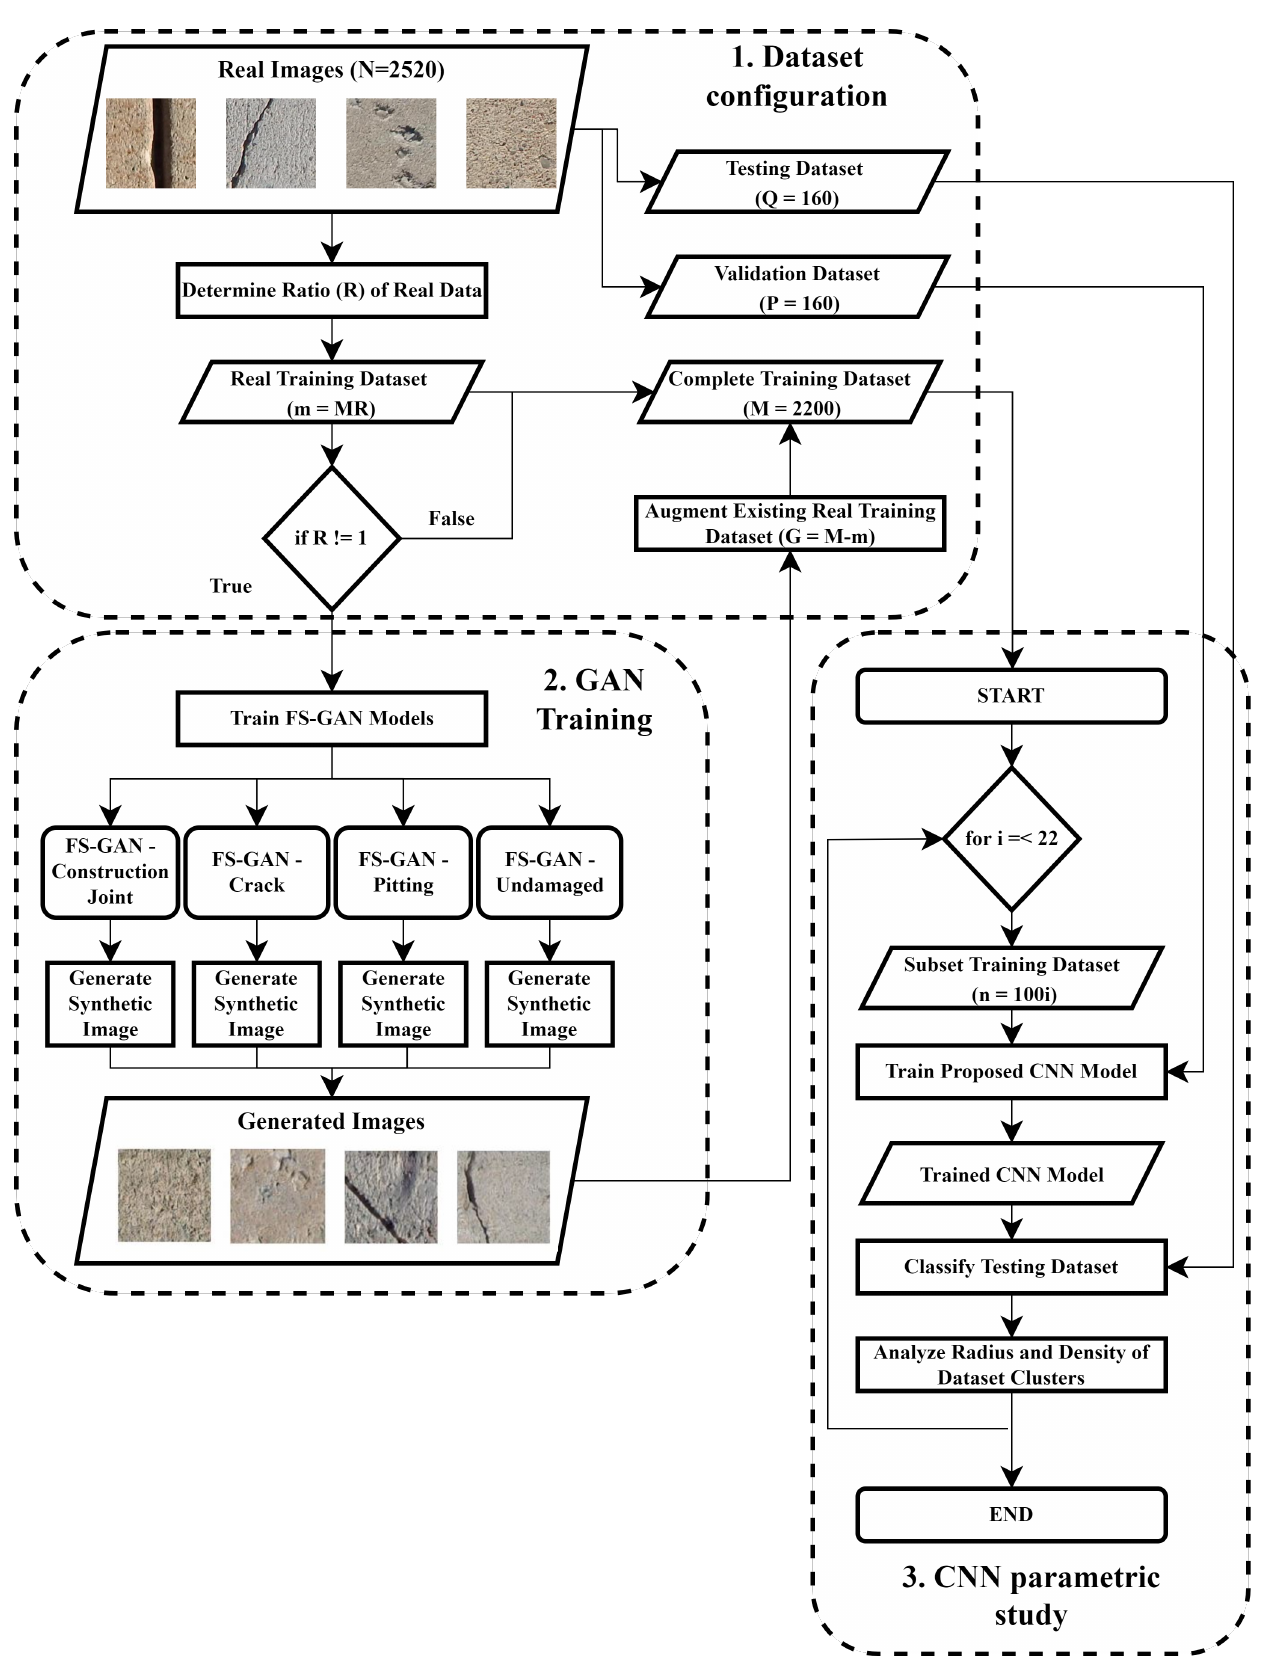
Figure 1. Proposed framework for the data augmentation of multiclass datasets using GANs for CNN